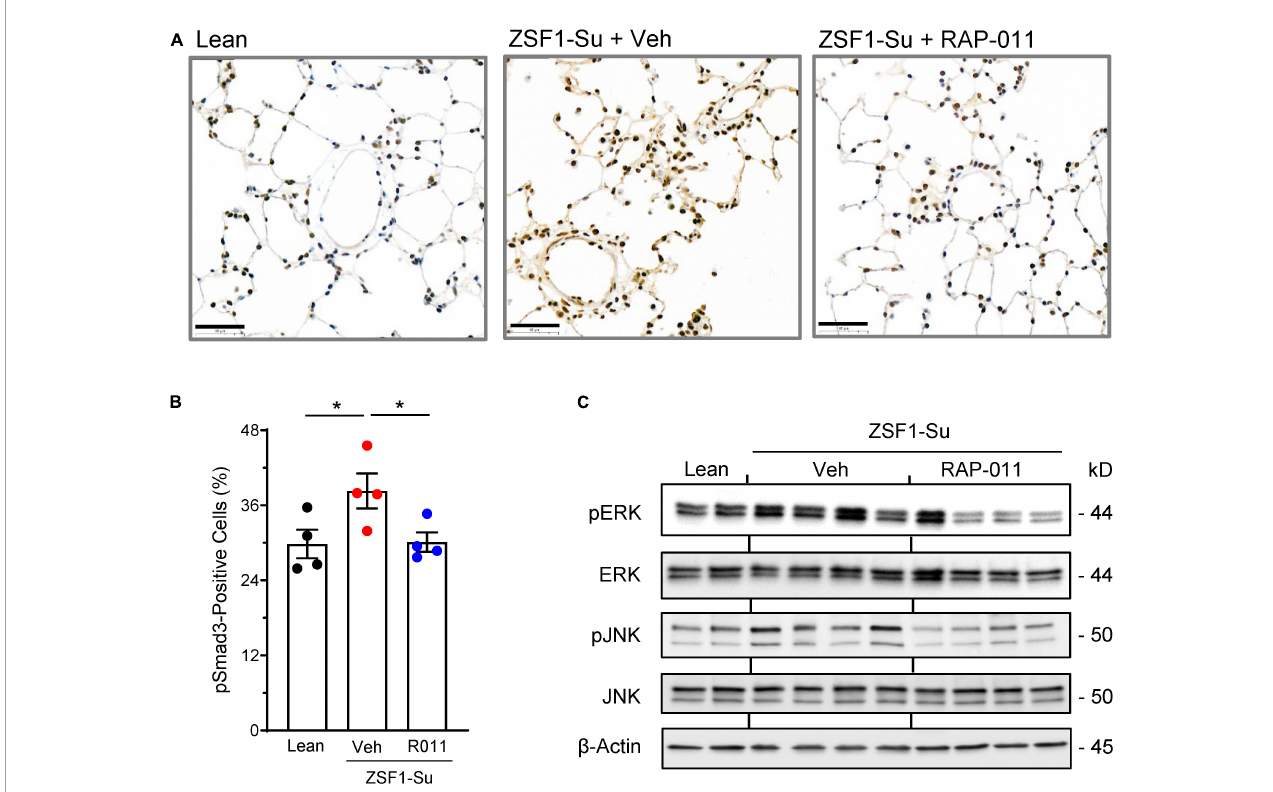
FIGURE6 ActRIIA-Fc inhibits canonical and non-canonical signaling associated with the TGF- β superfamily pathway in the lung of obese ZSF1-Su rats. (A) Representative images of lung sections immunostained for phospho-Smad3 (pSmad3) in obese ZSF1-Su rats and lean controls after treatment with ActRIIA-Fc (RAP-011, R011) or vehicle (veh, PBS) as in Figure 1A . Scale bar, 50 µ m. (B) Percentage of pSmad3-positive cells in lungs based on assessment of 30 high-magnification fields per rat. (C) Lung homogenates immunoblotted for phospho–extracellular-signal-regulated kinase (pERK), total ERK, phospho-c-Jun N-terminal kinase (pJNK), total JNK, and β -actin. Data are means ± SEM. Analysis by one-way ANOVA and Dunnett’s post-hoc test. * P <